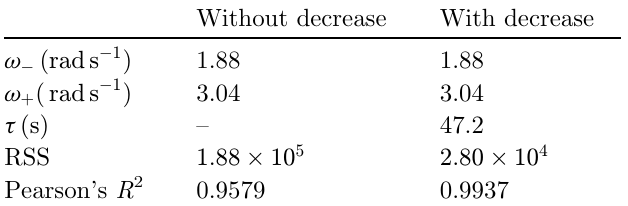
Table 4. In fl uence of the adding of an exponential decrease on the fi tting of an experimental curve represent- ing the pendulum motion along z . As the values in the table are algorithmically determined, no uncertainty is given here. Without decrease With